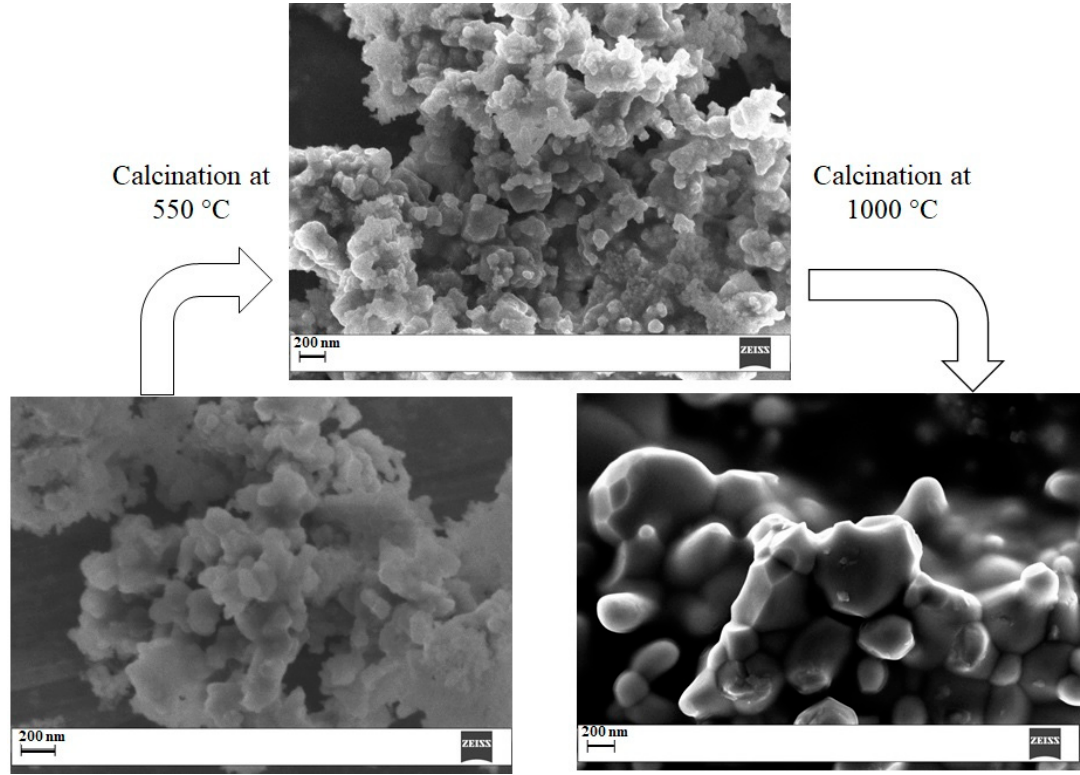
Figure 11. Change of morphology of Fe 3 O 4 /1.5CeO 2 at different calcination